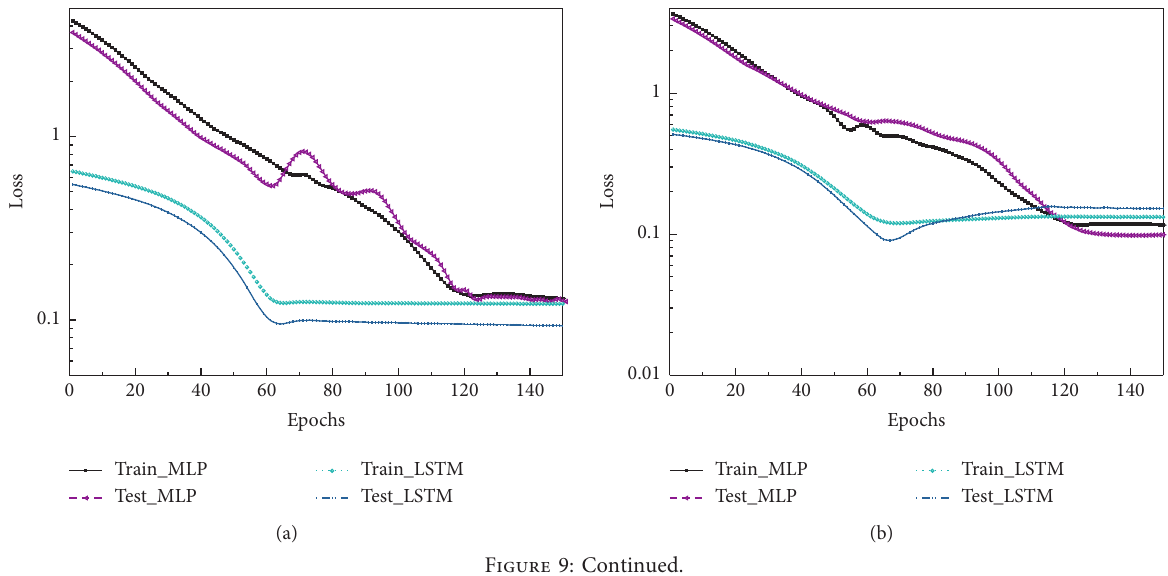
Figure 8: The first four POD modal coefficients predicted by MLP and LSTM at Ma � 0.53, 0.57, and 0.6. (a) a Ma � 0.57. (c) a 1 ( t ) at Ma � 0.6. (d) a 2 ( t ) at Ma � 0.53. (e) a 2 ( t ) at Ma � 0.57. (f) a 2 ( t ) at Ma � 0.6. (g) a 3 ( t ) at Ma � 0.53. (h) a 3 ( t ) at Ma �